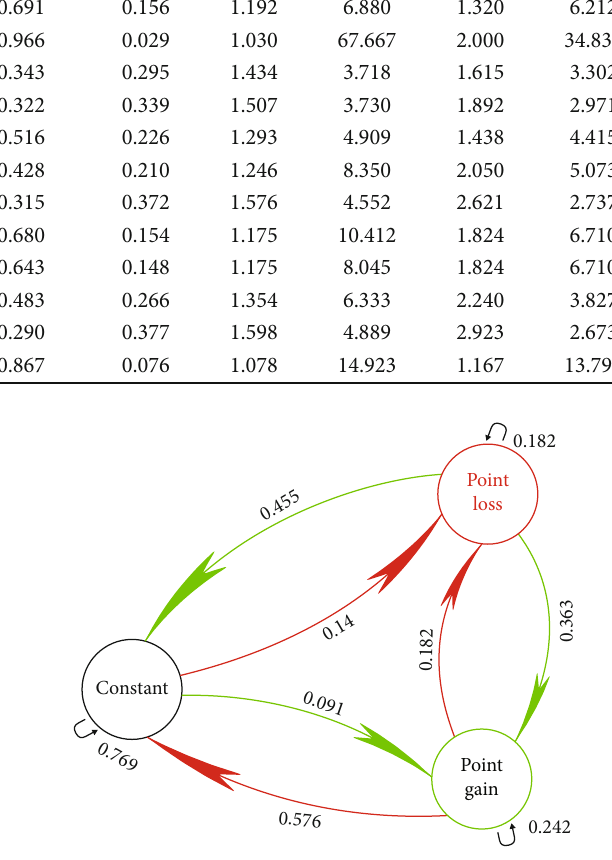
Figure 2: Access Bank Plc transition matrix and